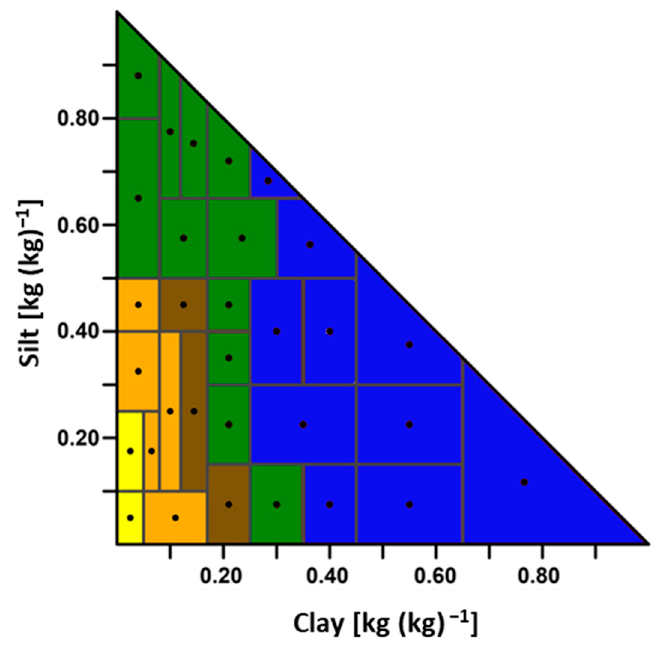
Figure 4. Soil texture classes of VDLUFA (TEX1 = yellow, TEX2 = ochre yellow, TEX3 = brown, TEX4 = green, TEX5 = blue) and 31 German Soil Science Society (DBG) soil texture classes (polygons with labeled centroid points (black dots)) as related to the clay and silt contents.